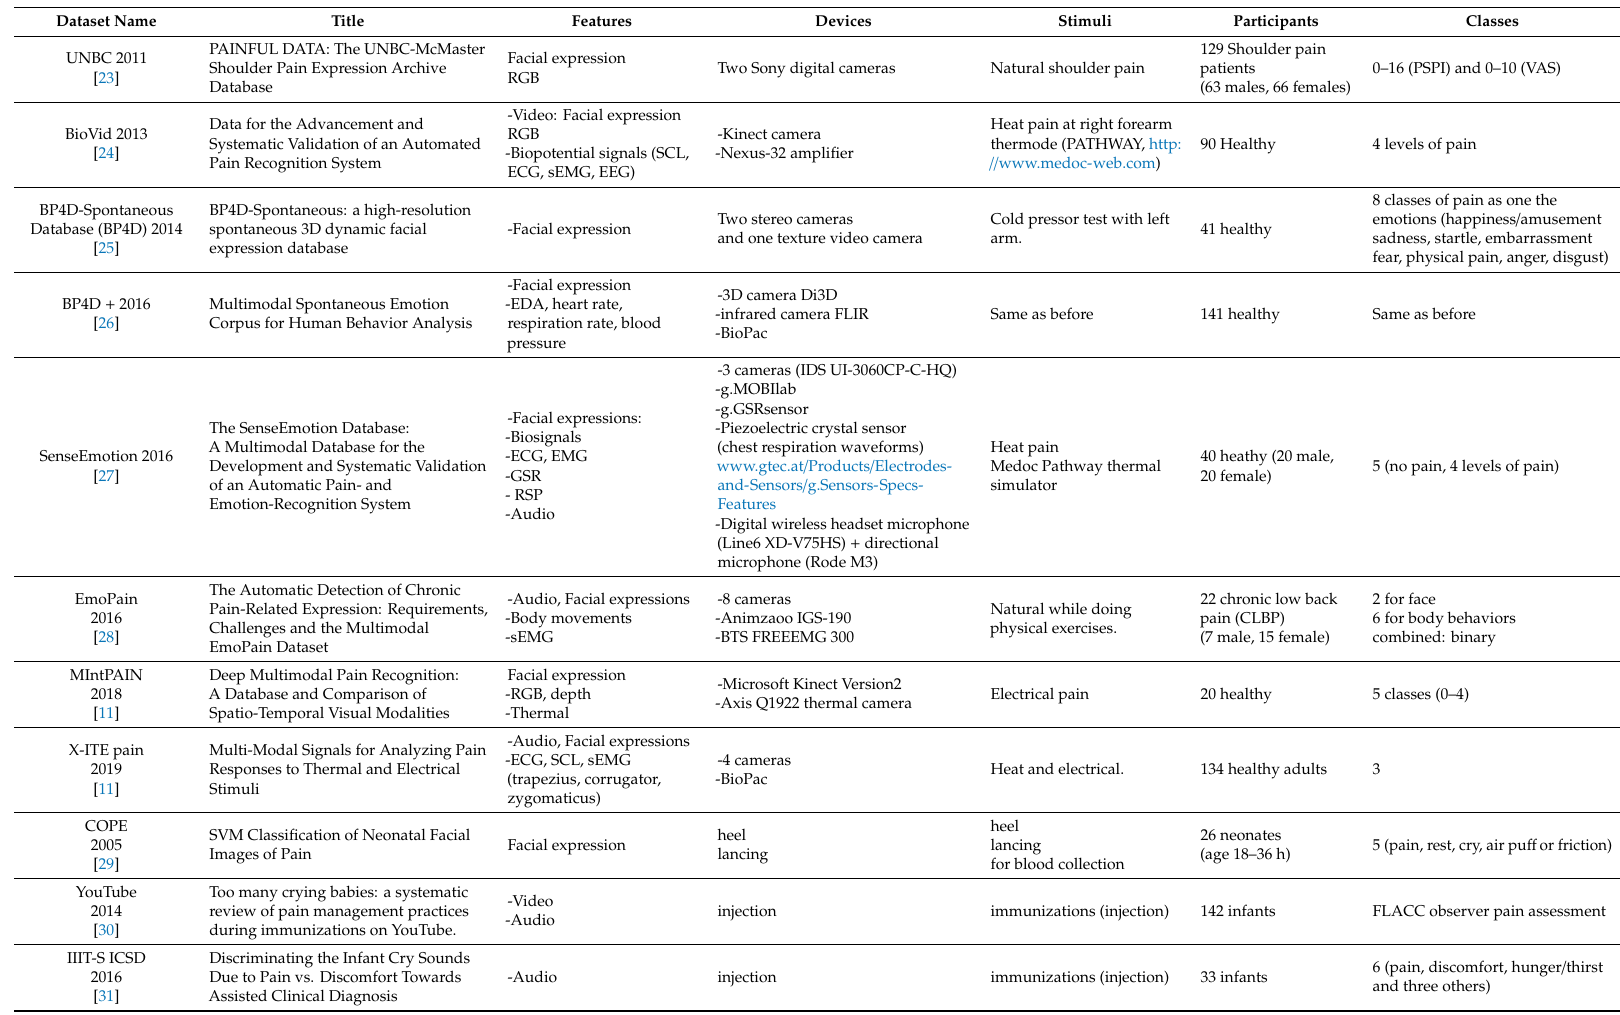
Table 2. Summary of pain-recognition data